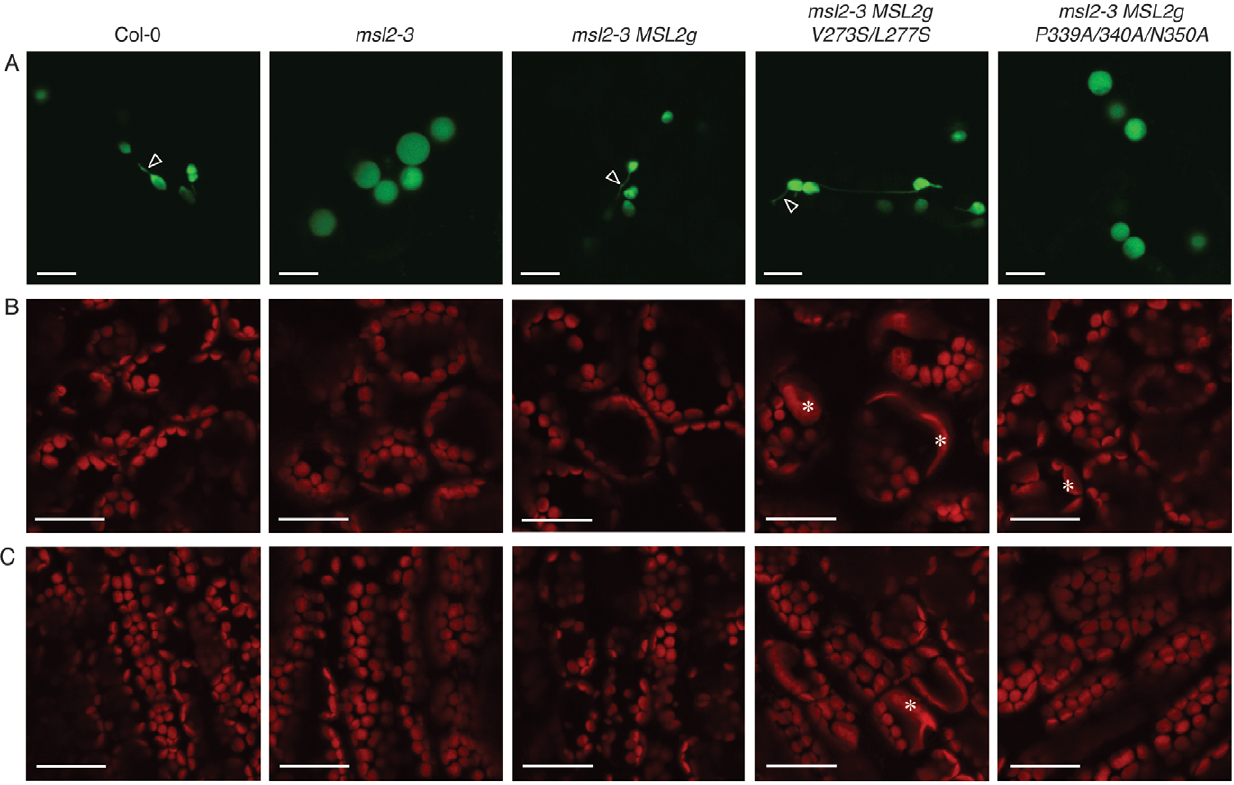
Figure 3. Expressing MSL2g mutants in the msl2-3 background affects plastid morphology. (A) Confocal laser scanning microscopy images of leaf epidermal cells transiently expressing the fluorescent stromal marker RecA-YFP. Arrows indicate stromules. Results are representative of at least 50 cells per genotype. Size bar is 10 microns. (B, C) Representative CLSM images of mesophyll cells from the leaf blade (B) and petiole (C) of 3 week-old T2 plants. Chlorophyll autofluorescence is pseudocolored red. In (B), the same region of each leaf (the lower right quadrant, midway between the vasculature and the leaf margin) was imaged. Asterisks mark enlarged chloroplasts. Size bar in (B) and (C) is 30 microns.